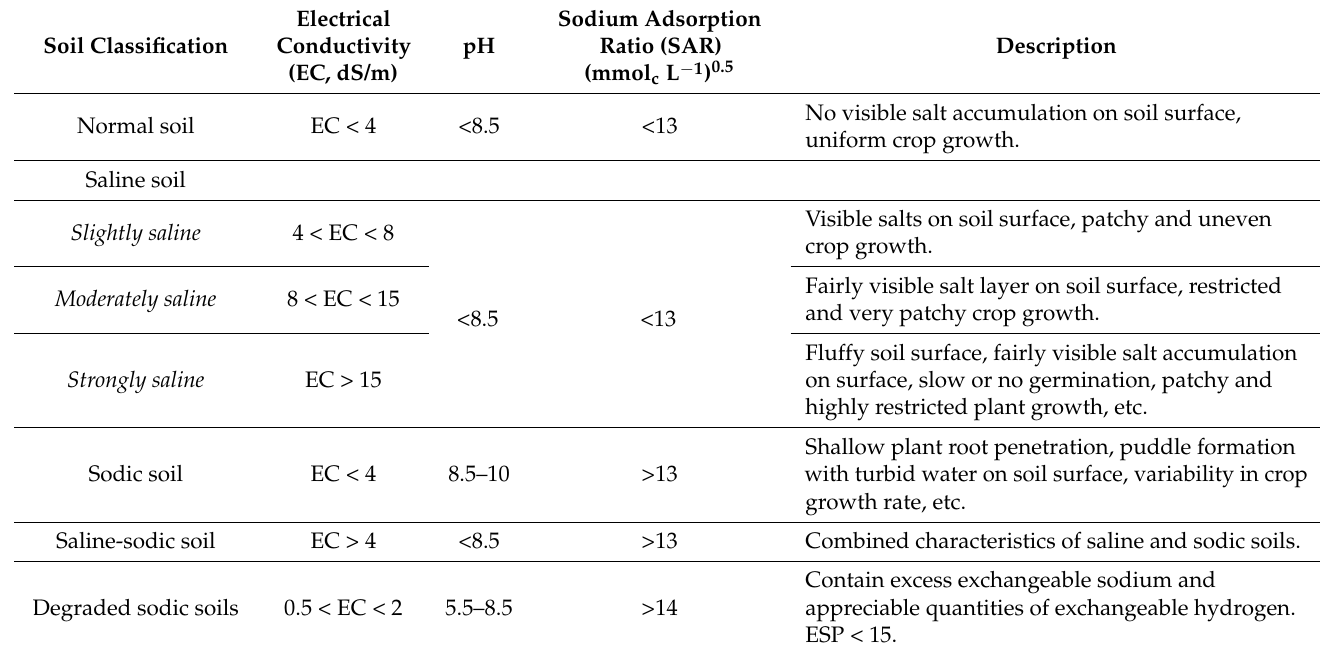
Table 1. Classification of salinity and sodicity affected soil based on physio-chemical properties (modified from Scherer, 1996 [10] and Alonge et al., 2019